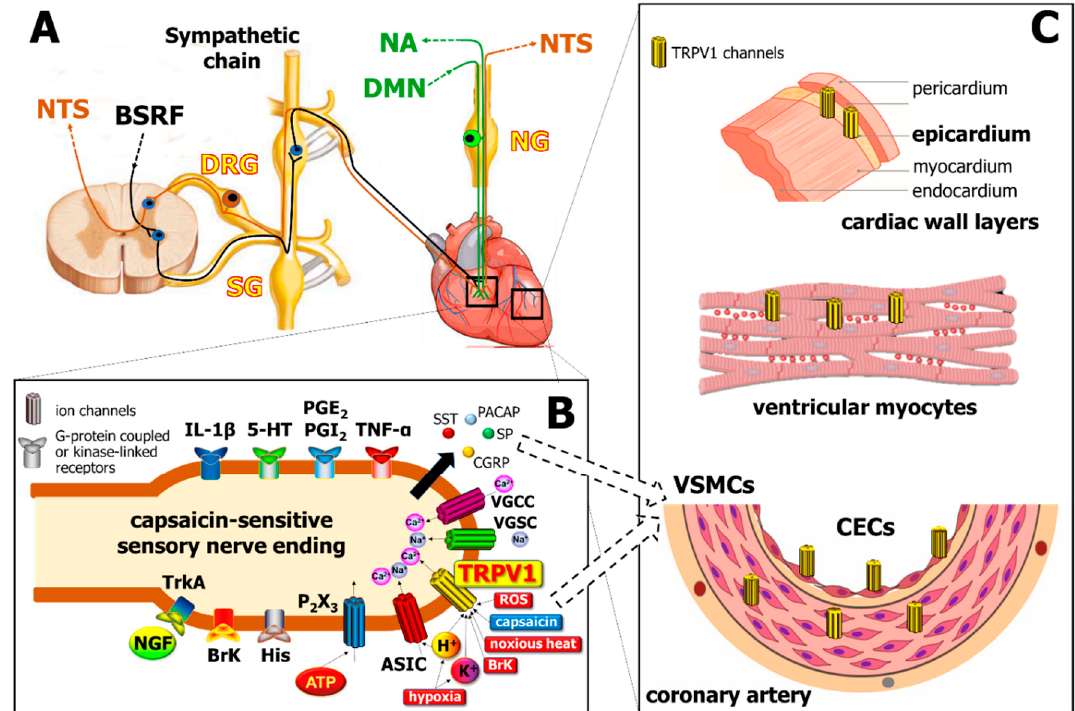
Figure 1. Localization of the transient receptor potential vanilloid type 1 (TRPV1) channel in different cells of the cardiovascular system. Panel ( A ): Cell bodies of primary sensory neurons innervating the heart are localized in the dorsal root ganglia (DRG) and transmit sensory signals to the nucleus tractus solitarius (NTS), as well as act as sensory efferents in the heart and the vasculature. Sensory nerves are coupled anatomically to sympathetic nerves which are derived from the brain stem reticular formation (BSRF), as well as to the vagus nerve (green), which projects afferents to the nucleus ambiguus (NA) and possesses motor efferents from dorsal motor nucleus (DMN). SG, sympathetic ganglion; NG, nodose ganglion. Panel ( B ): Several receptors co-localized with TRPV1 on the capsaicin-sensitive sensory nerve endings, which mediate a myriad of inflammatory signals including cytokines like tumor necrosis factor alpha (TNF- α ) and interleukins (e.g., IL-1 β ), bradykinin (BrK), histamine (His), nerve growth factor (NGF; acting on Tropomyosin receptor kinase A—TrkA receptors), prostaglandins (e.g., PGE2, PGI2), serotonin (5-HT), and purine mediators (acting at P2 × 3 purinergic receptors). Noxious stimuli such as ischemia/hypoxia, increased level of reactive oxygen species (ROS), noxious heat (> 43 °C), increased levels of K+ or H + activate TRPV1, and H + also stimulate acid-sensitive ion channels (ASIC). Further ion channels, such as voltage-gated Na + and Ca 2+ channels (VGSC, VGCC) may also increase intracellular Na + and Ca 2+ levels, thereby inducing the release of peptide mediators, including calcitonin gene related peptide (CGRP), substance P (SP), somatostatin (SST), and pituitary adenylate cyclase-activating polypeptide (PACAP). Panel ( C ) demonstrates the localization of TRPV1 channels on different cell types of the heart (CECs, cardiac endothelial cells; VSMCs, vascular smooth muscle cells).